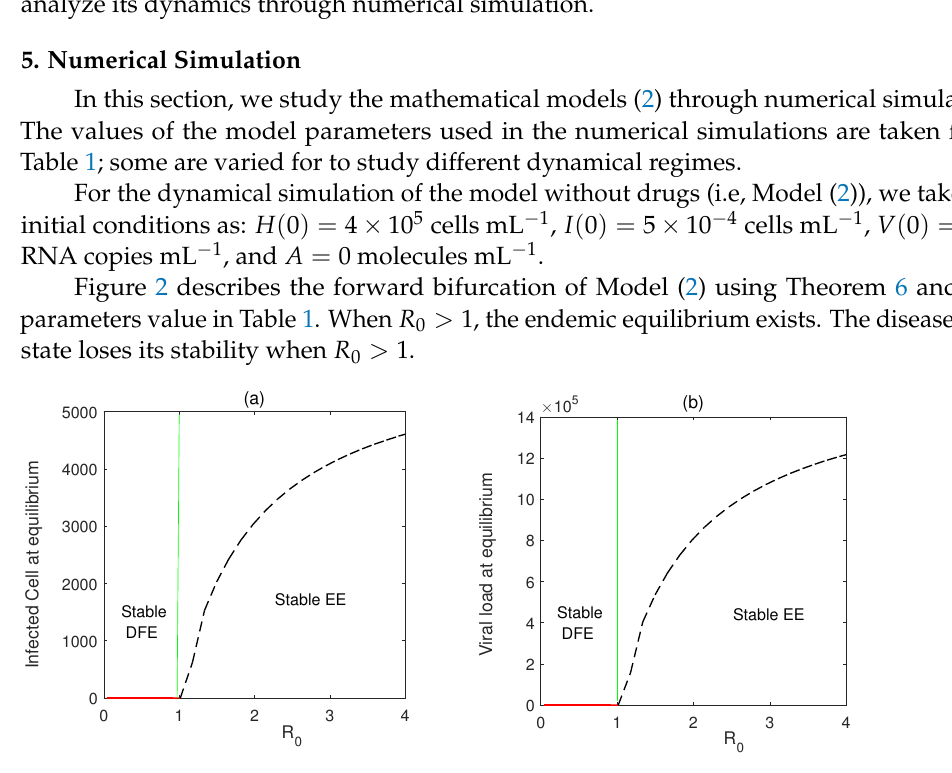
Figure 2. ( a , b ) Forward bifurcation diagram of Model (2) using Theorem 6. Red curves represent stable disease-free equilibria (DFE) and the black-dashed line denotes stable endemic equilibria (EE).